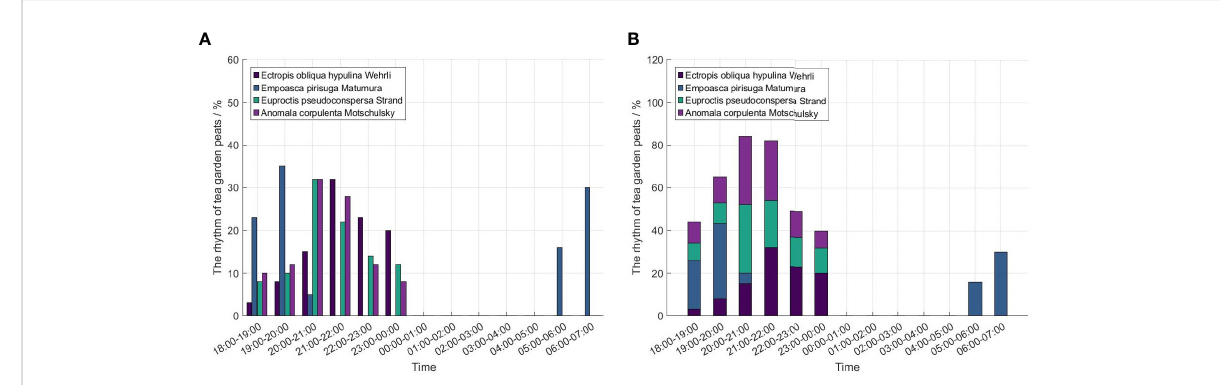
FIGURE 7 The phototactic rhythm of tea garden pests. (A) The phototactic rhythm of Ectropis Obliqua Hypulina Wehrli, Empoasca Pirisuga Matumura, Euproctis Pseudoconspersa Strand, Anomala Corpulenta Motschulsky in the tea garden, (B) The Cumulative chart of Rhythm for different pests in tea garden.